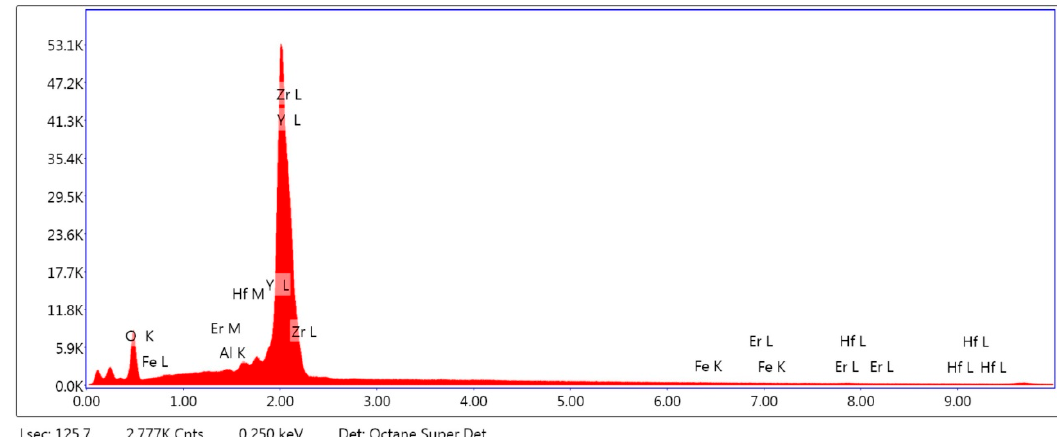
Figure 1. Energy dispersive spectroscopy analysis of Celtra Duo (ZLS).